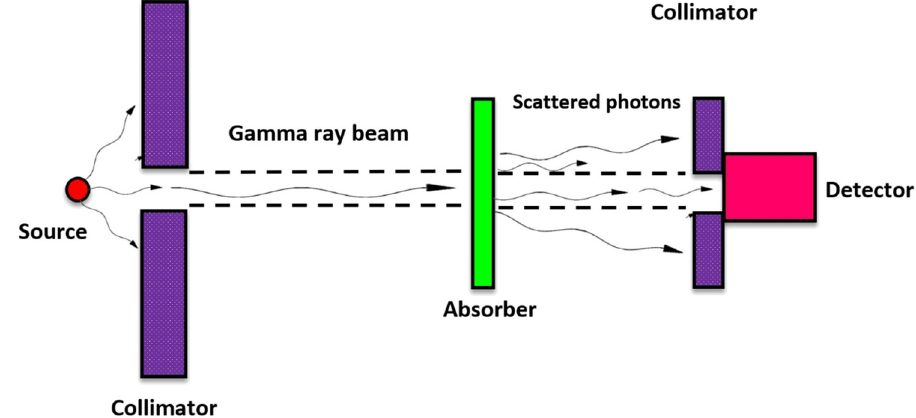
Figure 2: A typical setup for gamma - ray transmission